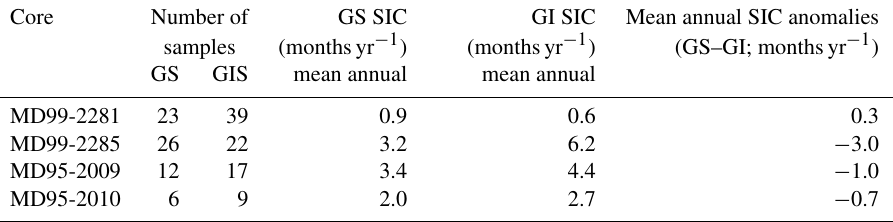
Table 2. SIC duration anomalies. Core Number of GS SIC GI SIC Mean annual SIC anomalies